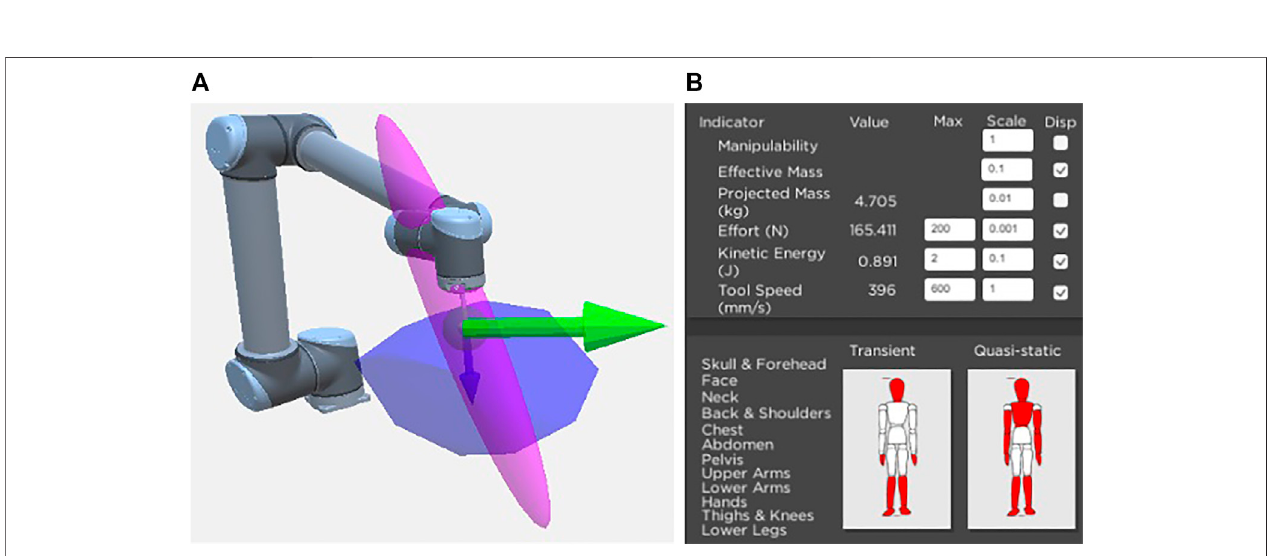
FIGURE 5 | Display of multiple safety criteria in the 3D scene (A) and in a 2D interface (B) , showing the risks for different body parts for transient and quasi-static impacts.